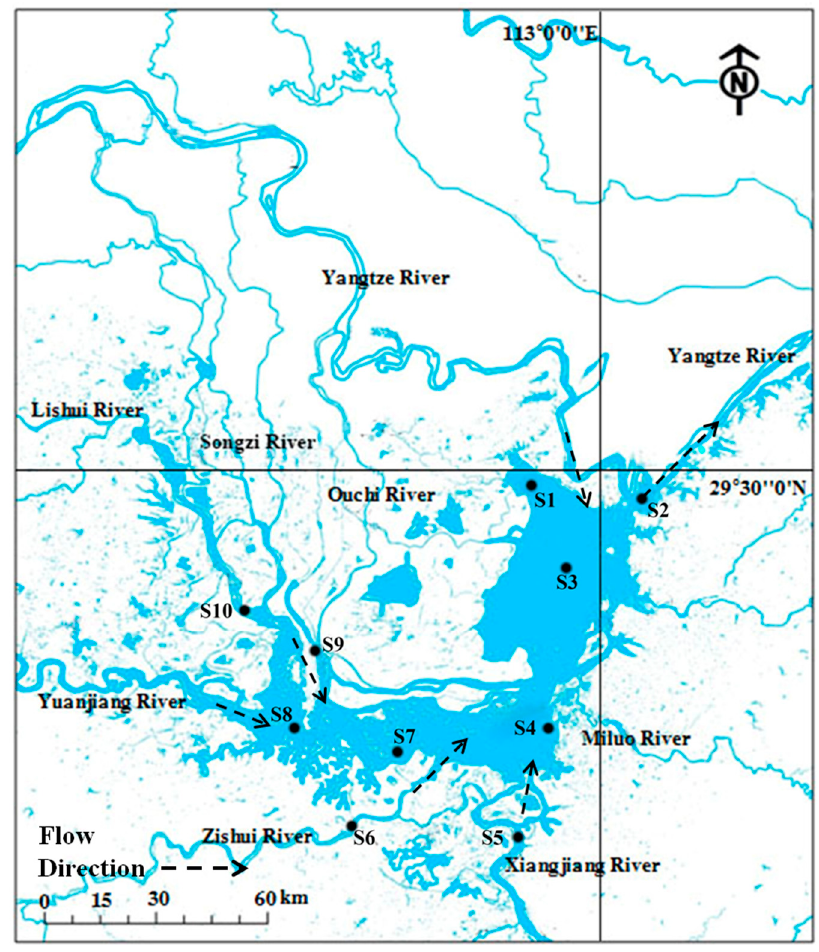
Figure 1. Sampling site at the study area.